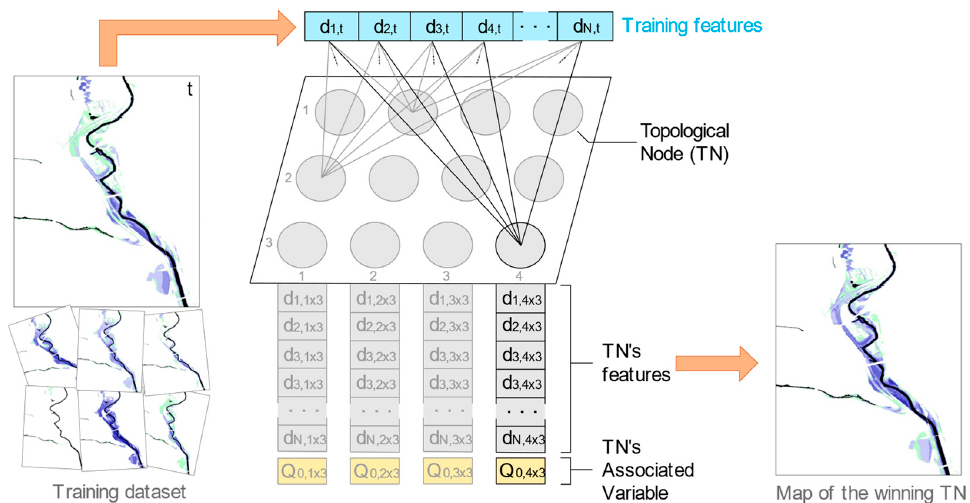
Figure 2. Illustration of an SOM utilized in this work during the training step, when the IM of time t , composed by N (40, 482) instant water depths d 1, t , d 2, t , . . . , d N , t , is associated to the TN 4 × 3 by similitude. The values of such winning TN ( d 1,4 × 3 , d 2,4 × 3 , . . . , d N ,4 × 3 ) are updated following the new learned values.